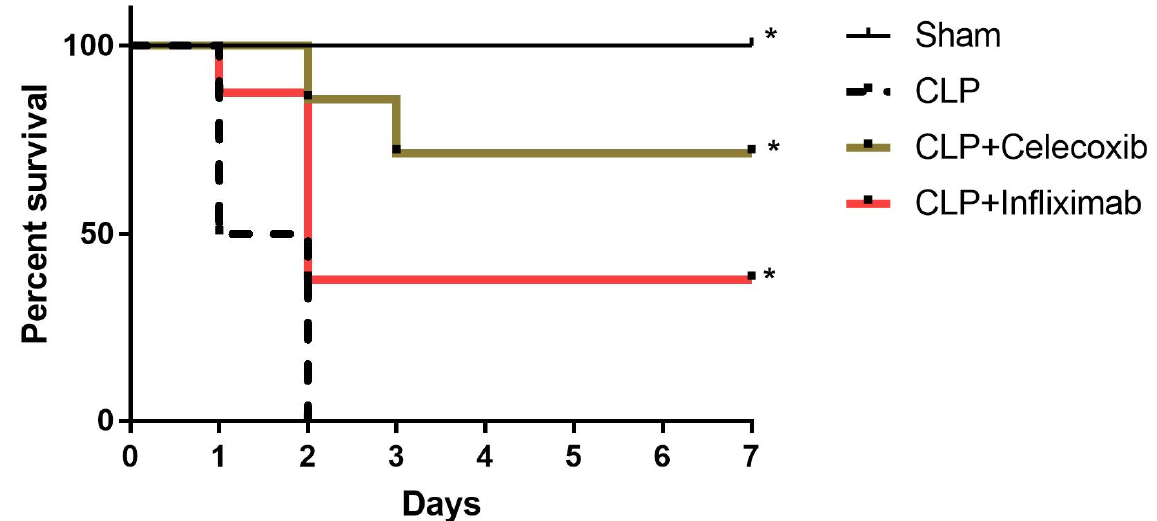
Figure 1. The effects of the induction of sepsis and treatment with CLX and IFX on survival. Cecal ligation and puncture (CLP) surgery resulted in a decrease in the survival rate, reaching 0 % survival at the end of day 2, while celecoxib (CLX) (0.1 mg/kg, p.o), which was administered to the rats 2 h after CLP, improved survival at the end of the study by 50%. Infliximab (IFX) (5 mg/kg, s.c), which was injected into the rats 2 h following induction of sepsis, increased survival by the end of the seventh day, reaching 37.5% compared to the septic untreated group. The survival rate of rats in the sham group of the study was 100%. Rats were monitored for 7 days. Data are described as a percentage of the survival of the rats ( n = 8 rats per group). * refers to a significant difference at p < 0.05 compared to the CLP group.